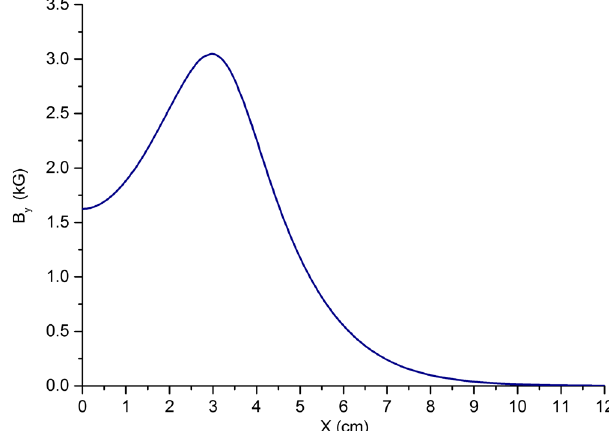
FIG. 4. Dependence of the vertical magnetic field B horizontal transverse coordinate at the undulator median plane for the period 6.8 cm.